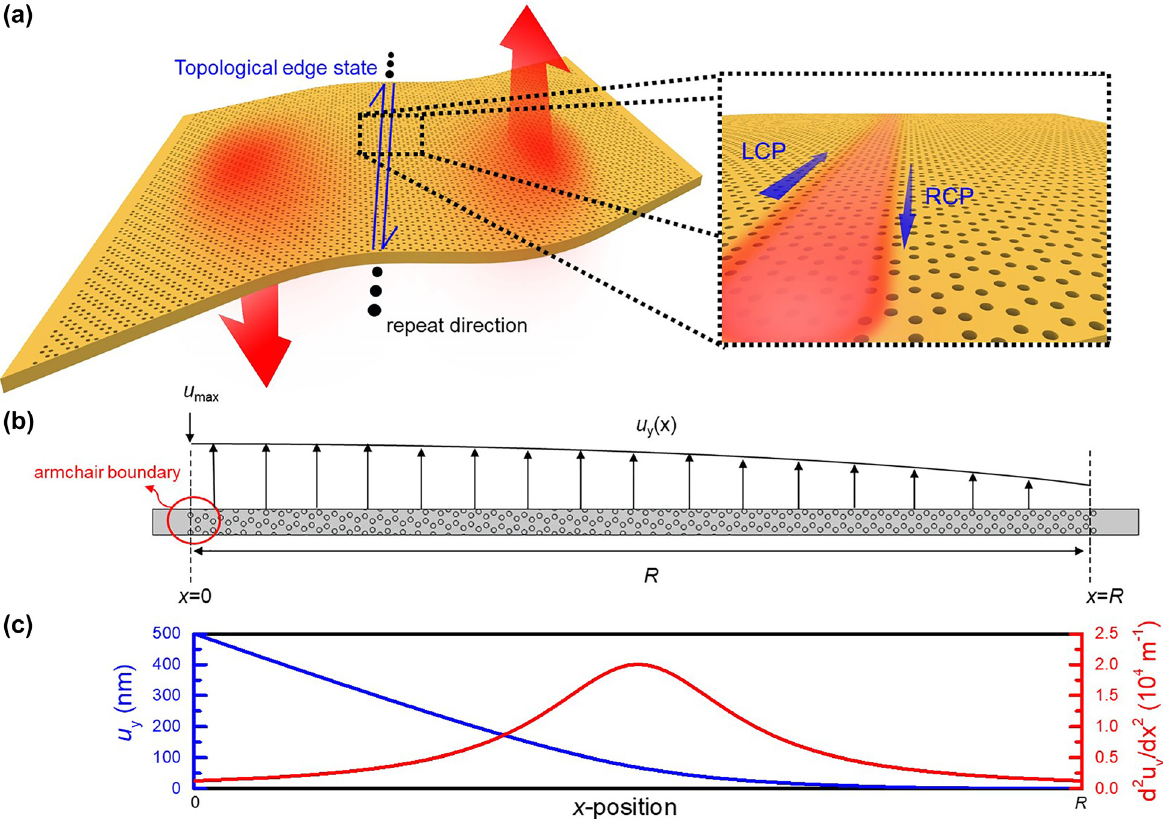
Figure 2: The schematic diagrams of the proposed chiral structure and the applying displacement. (a) The schematic diagram of the chiral structure, which supports the strain-induced topological edge state. (b) The schematic diagram of the honeycombsuperlatticeandthecontinuous y -displacement,whichisthefunctionof x anddistributesfrom x =0to x = R ,andthe x -axisisalong thezigzagdirectionofthehoneycomblattice.(c)Thecontinuousdisplacementfunctions.Thebluelineindicatesthedistributionof u y ,andthe red line indicates the distribution of ∂ 2 u y / ∂ x 2